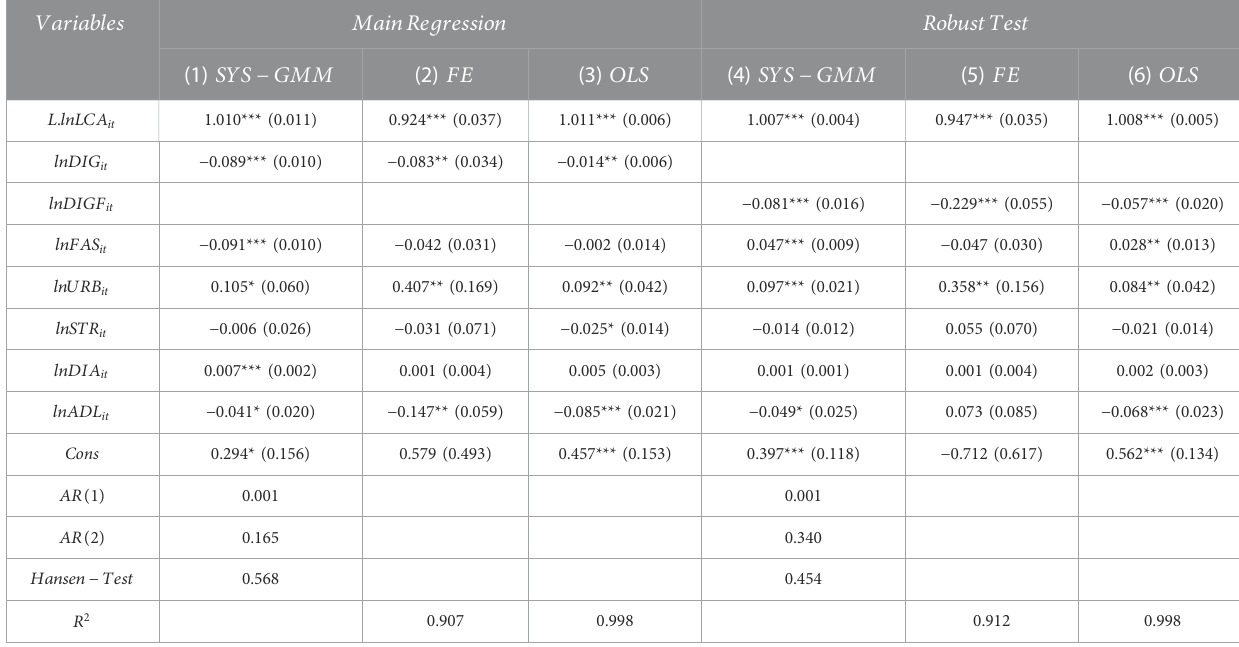
TABLE 5 The results of benchmark